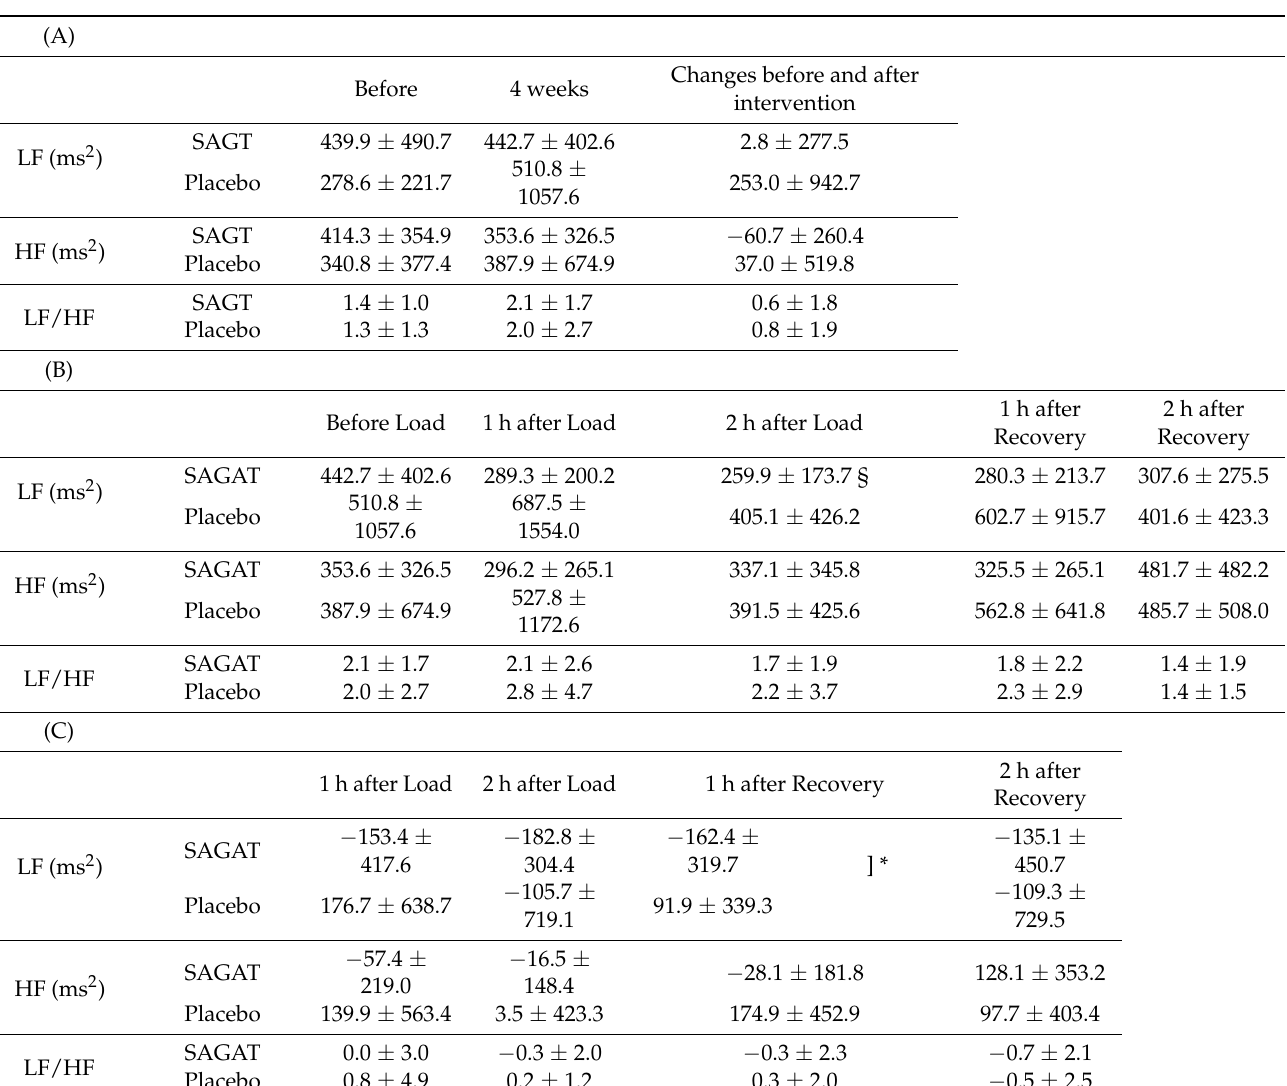
Table 3. Autonomic nervous